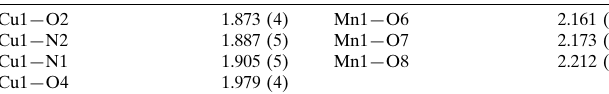
Selected bond lengths (A˚ ).